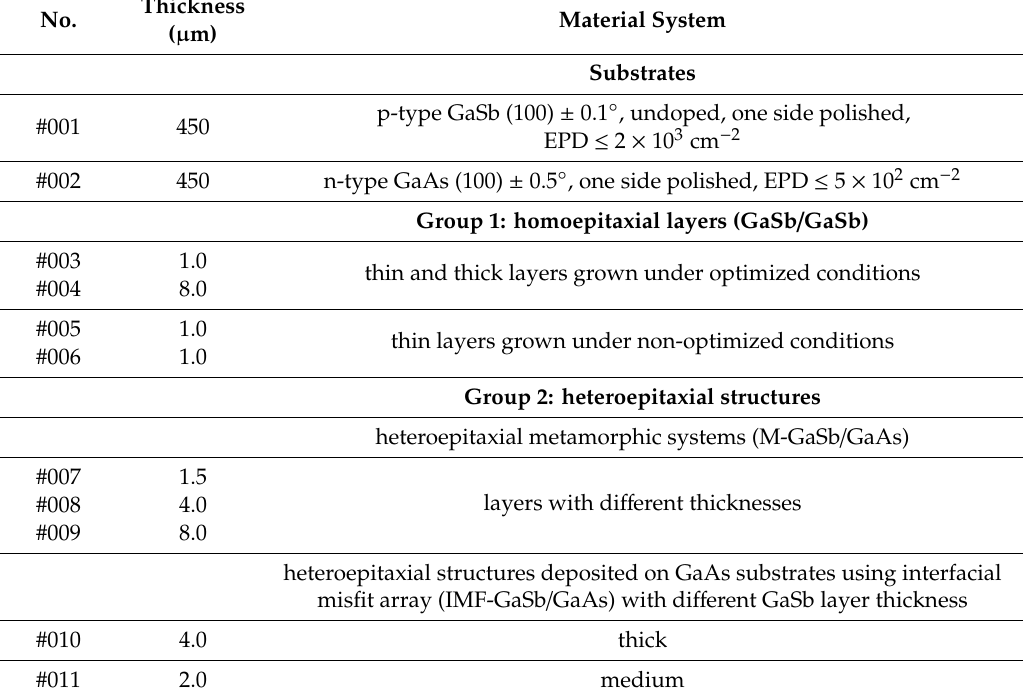
Table 1. Structures used for evaluating the threading dislocation